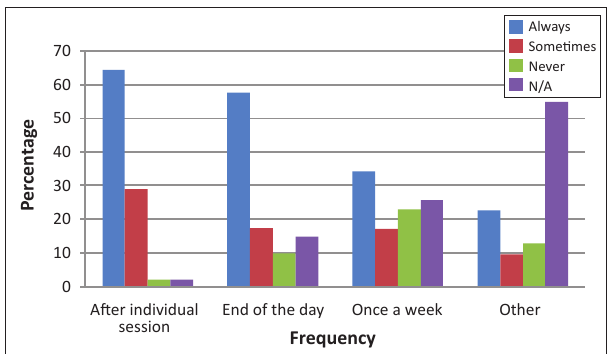
FIGURE 1 : Frequency of sterilising audiology equipment.